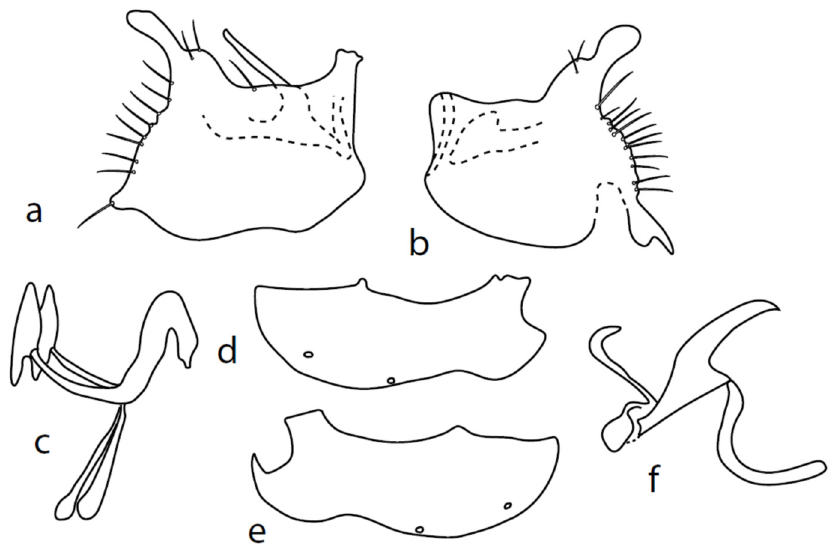
Figure 4. M. nevadensis sp. nov., genitalia: ( a ) = right epandrial lamella, ( b ) = left epandrial lamella, ( c ) = postgonites, ( d ) = hypandrium from left, ( e ) = hypandrium from right, ( f ) = phallus from left. Microphor pallipes sp. nov. Female: similar to male. Head dichoptic, ventral part of eye (below line) larger than dorsal part. Frons approximately 0.15 mm wide at middle, slightly subshiny. Mesoscutum Type material: black, microtrichose, without stripes. Legs without conspicuous setae. Halter yellow. Abdomen much shorter setose than in male.